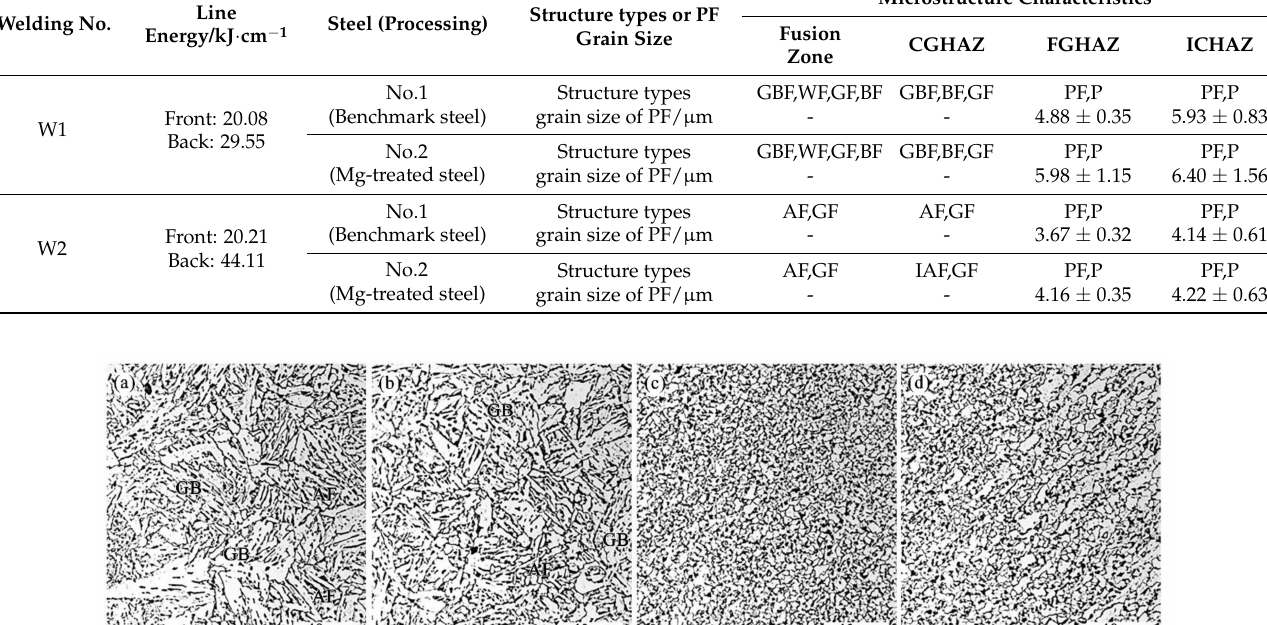
Table 6. Microstructure characteristics of the different zones for the steel. Welding No.